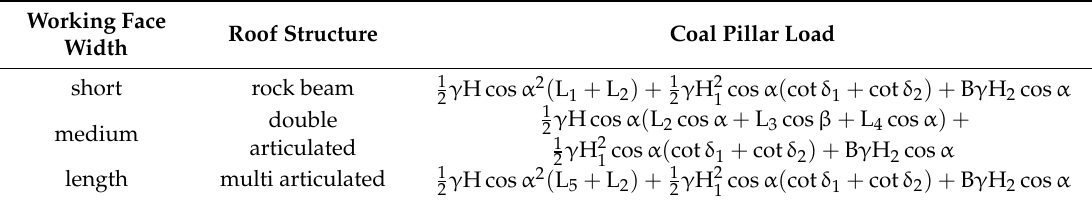
Table 1. Sectional coal pillar stability under di ff erent structural